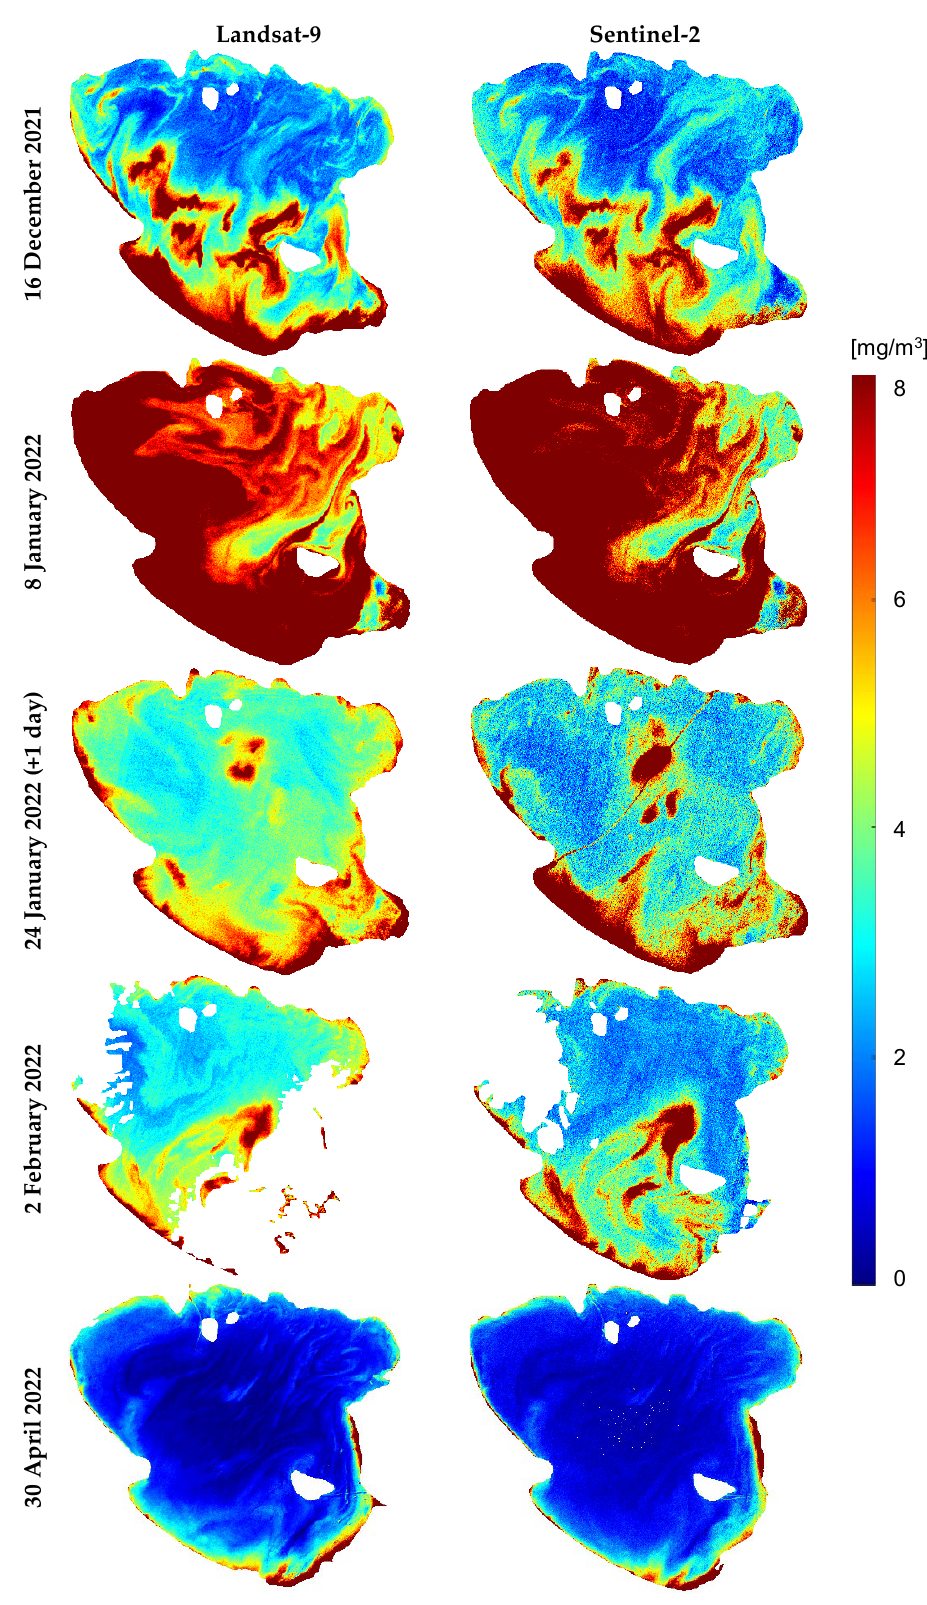
Figure 9. Chl-a maps derived from Landsat-9 and Sentinel-2 imagery in Lake Trasimeno using BOMBER.